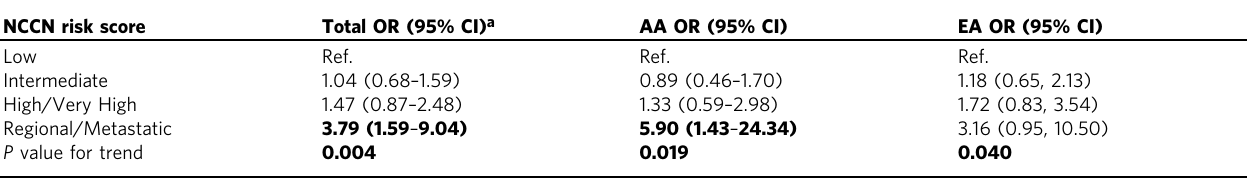
Table 1 A high score for suppression of tumor immunity associates with National Comprehensive Cancer Network (NCCN) Risk Score for metastatic prostate